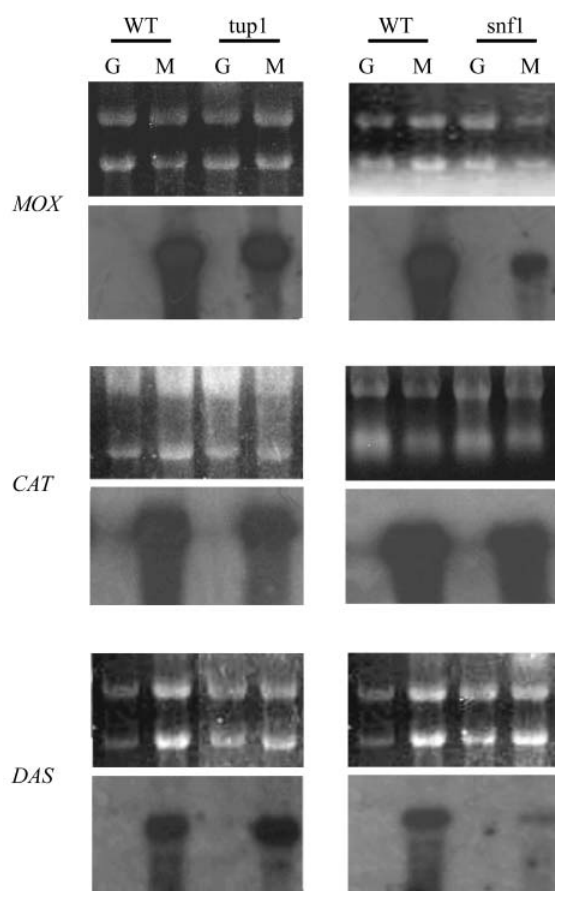
Figure 3 - Expression of MOX , CAT and DAS in WT, tup1 and snf1 cells. Northern blotting of samples collected after shifting cells from repressing (cells grown overnight in glucose 5% - time 0) to derepressing conditions (methanol 1%) for 6 h: G - glucose; M - methanol. rRNA bands of samples used in each filter are shown in agarose-formaldehyde gels stained with ethidiumbromidepriortoblotting.TheprobesusedaredescribedinMate- rials and